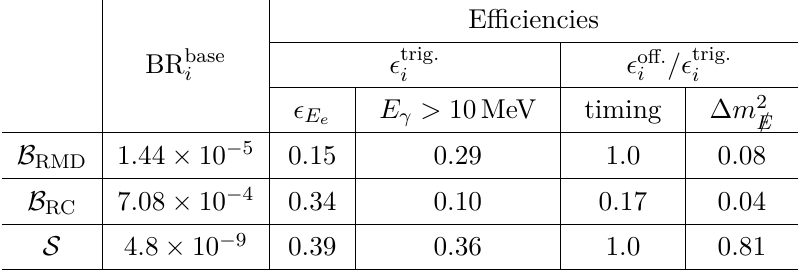
Table 3 . Efficiencies in each kinematic selection for the dedicated run (section 3). For signal, F V − A is fixed to 10 9 GeV. The “timing” selection refers to the tighter coincidence requirement in µe the offline cuts, as compared to the trigger selection. See section 2.1 for